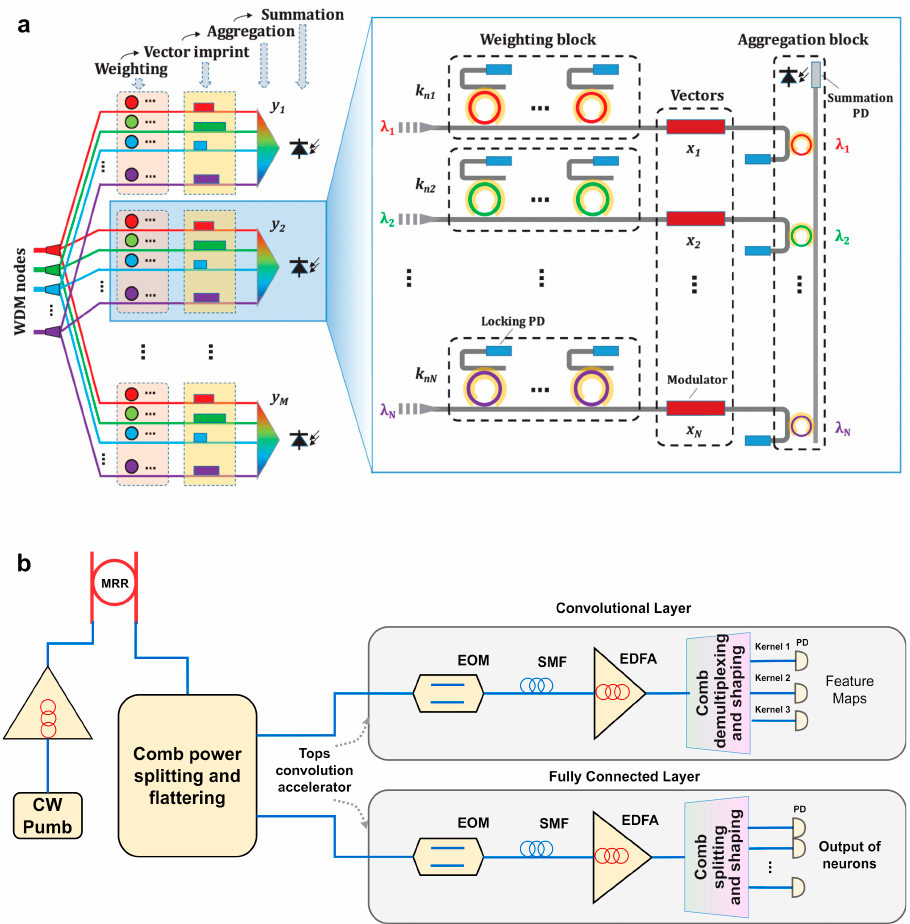
Figure 11. Implementation by resonance of light . ( a ) Hitless weight-and-aggregation architecture for M × N vector-matrix multiplier [96]. ( b ) Experimental schematic of the optical CNN [8]. ( a ) Reprinted with permission from Ref. [96]. Copyright © 2020 IEEE. ( b ) Reprinted with permission from Ref.